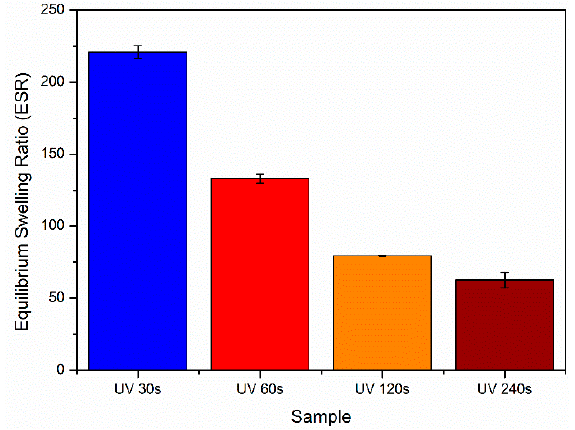
Figure 8. The equilibrium swelling ratio of HA/PEG hydrogels with different UV exposure time. Error bars represent the SD of measurements performed on 4 samples.